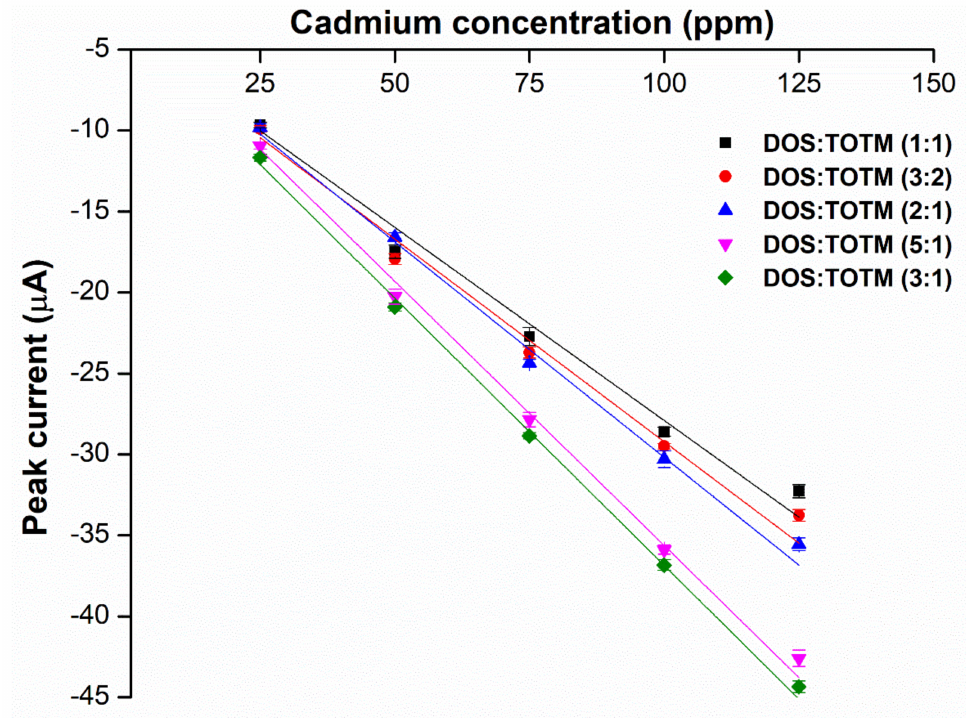
Figure 5. Relationship between peak current of the different weight ratios of DOS:TOTM hybrid plasticizer sensors and different concentrations of cadmium(II), ( n =